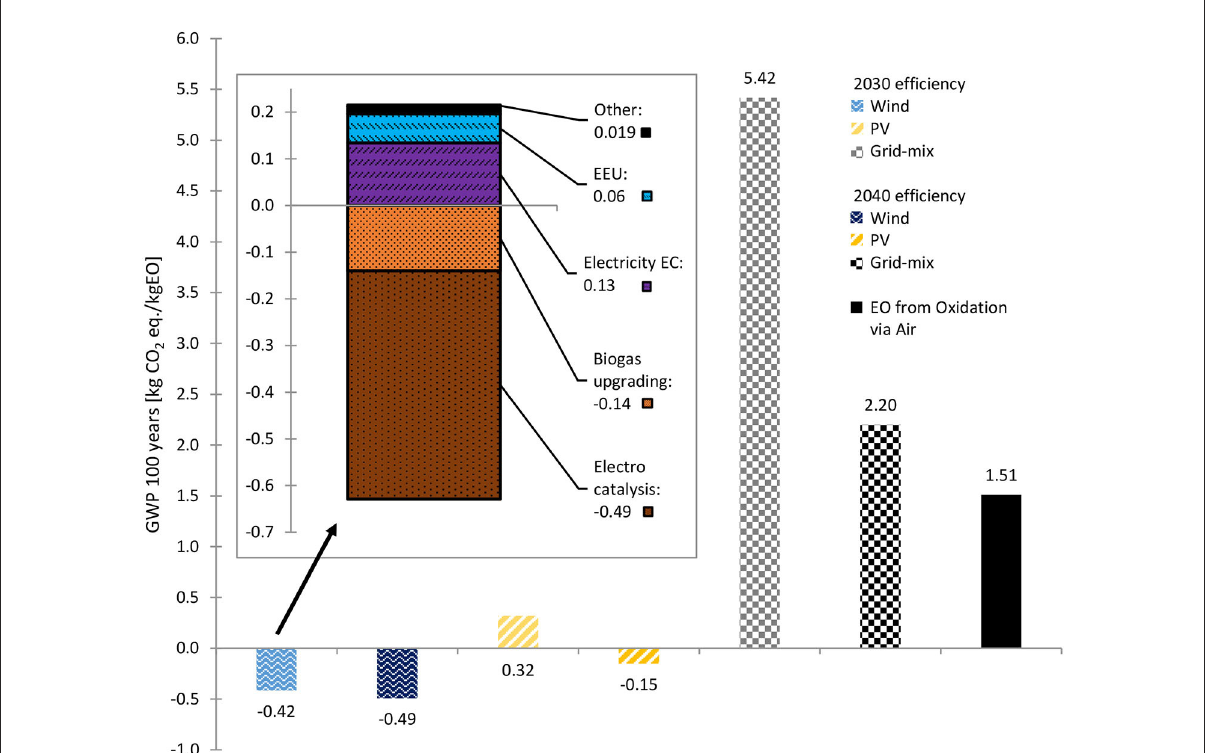
FIGURE6 GWP 100 years of 2030 and 2040 biogenic CO 2 scenarios with different energy supplies and of conventionally produced EO. Stacked diagram: GWP 100 years share of each process, for 2030 efficiencies, wind power and biogenic CO 2 . Source: own data and illustration except for data of EO from Oxidation via Air, which are taken from (GaBi sphera,